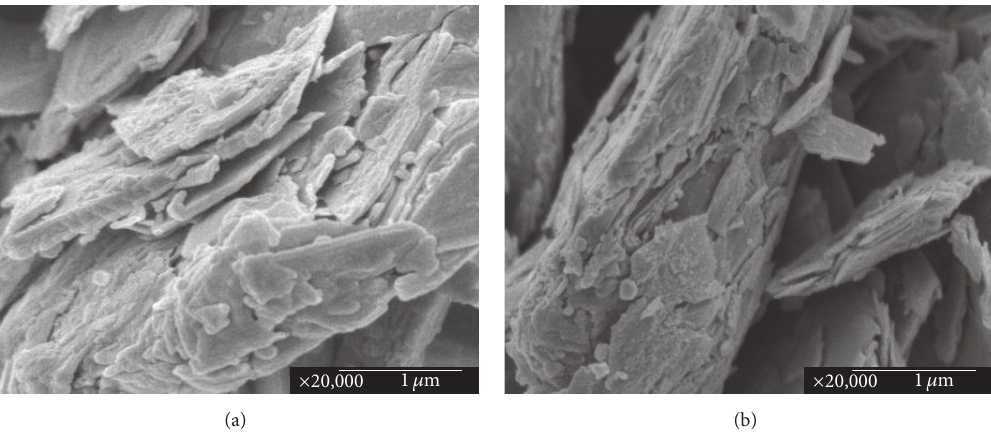
Figure 10: SEM diagrams of fresh MoS 2 catalysts (a) and spent MoS 2 catalyst